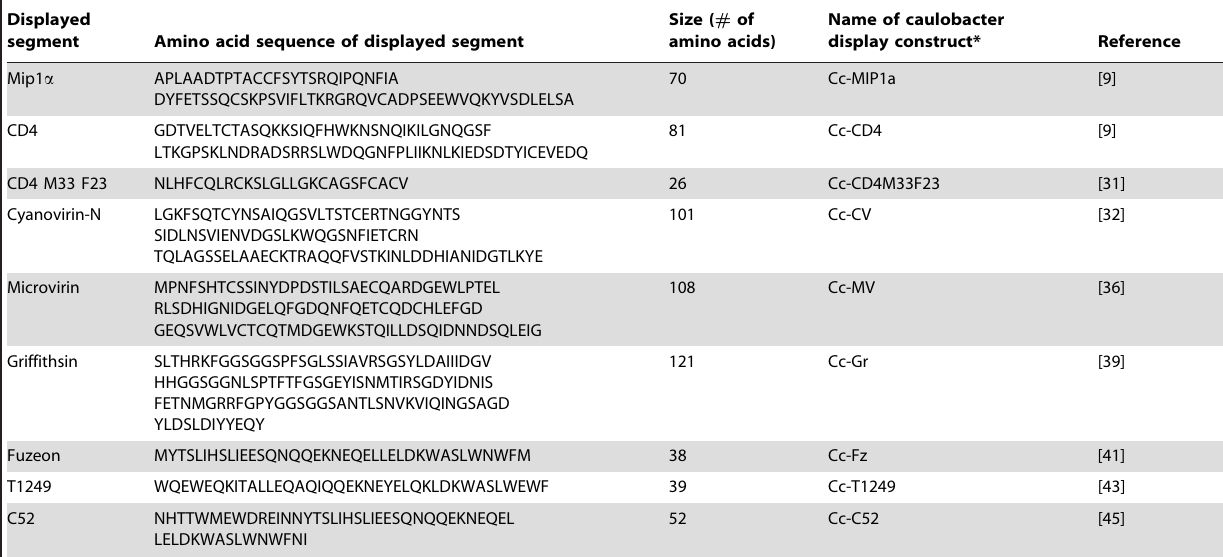
Table 1. Displayed Protein